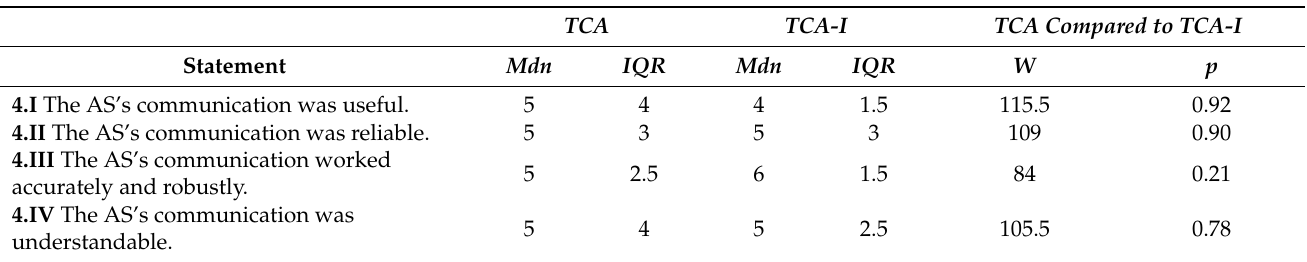
Table 5. Summary of pairwise comparison for Wilcoxon rank-sum test of statements concerning an evaluation of the participant’s trust in the communication design.